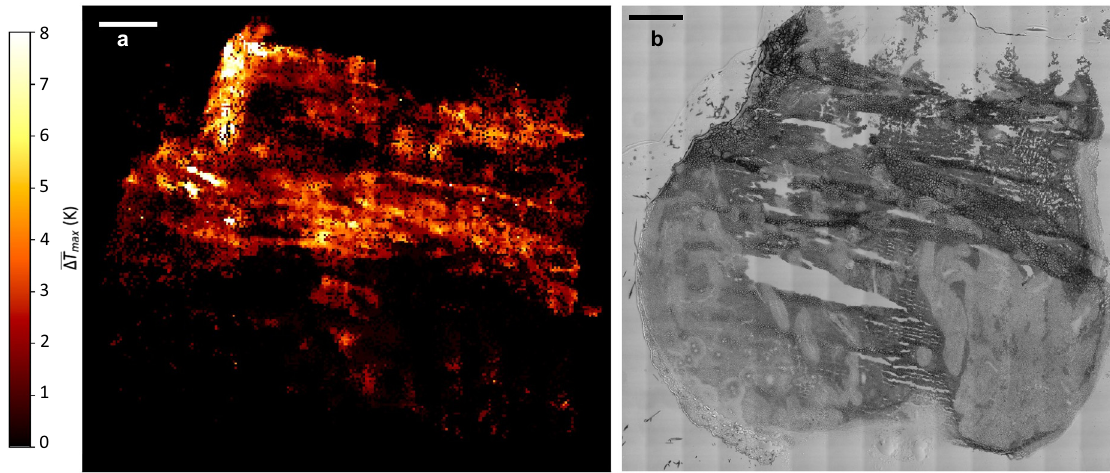
Figure 1: B16 melanoma biopsy imaged by super - resolution photo - activated thermography. ( a ) Super - resolved photo - thermal image of an unstained murine B16 melanoma biopsy; λ color codes for pixels where no photo - thermal signal has been detected above the 0.1 K sensitivity of the thermal camera. ( b ) Transmitted - light image of the same biopsy imaged in ( a ) ; scale bar = 1